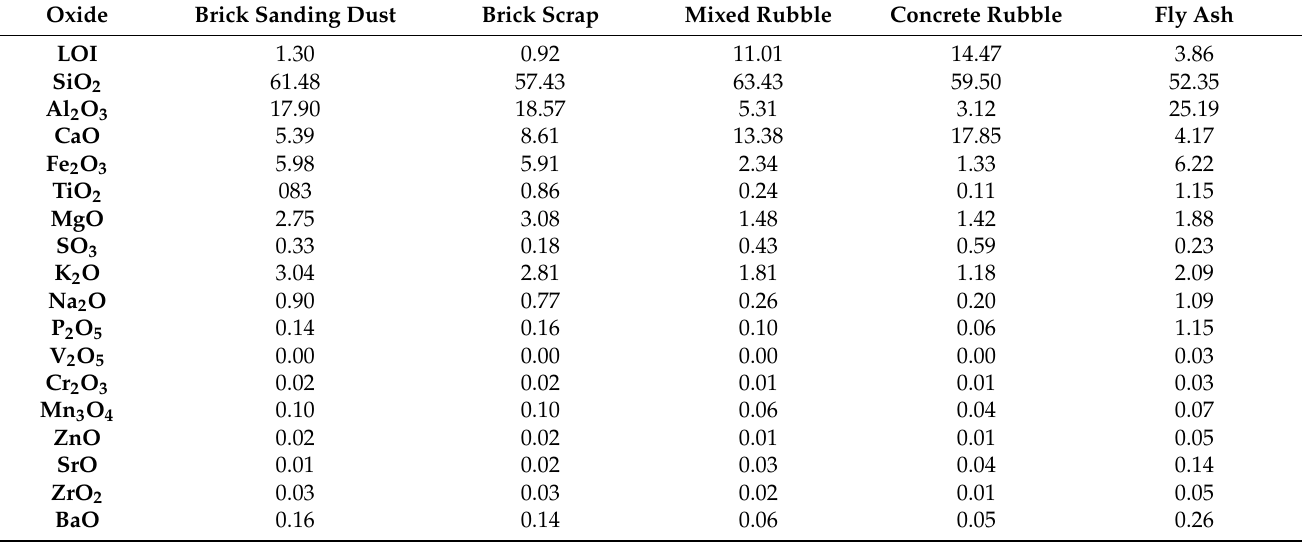
Table 1. Chemical composition of the residual materials used in wt.%, determined by XRF analysis.